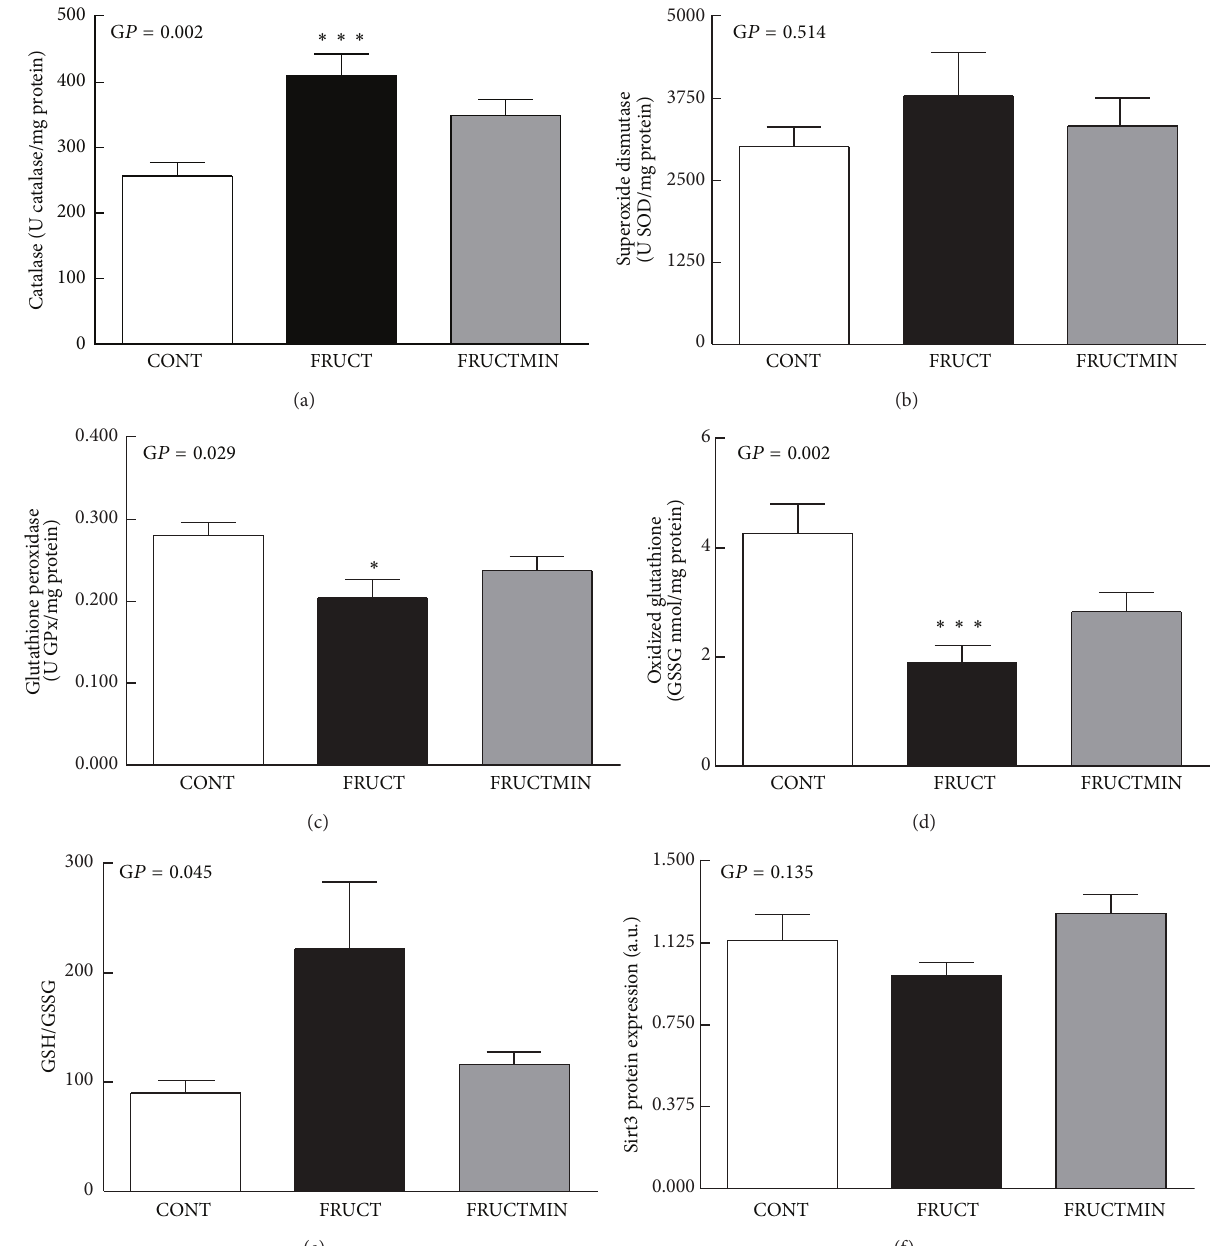
Figure 7: Redox state markers in liver. (a) Catalase (U catalase/mg protein; 𝑛 = 7 ), (b) superoxide dismutase (U SOD/mg protein; 𝑛 = 7 ), (c) glutathione peroxidase activities (U GPx/mg protein; 𝑛 = 7 ), (d) oxidized glutathione content (nmol/mg protein; 𝑛 = 7 ), (e) GSH to GSSG ratio ( 𝑛 = 7 ), and (f) sirtuin 3 protein expression (arbitrary units (a.u.); 𝑛 = 5 -6), at the end of the dietary intervention. Results were expressed as mean ± standard error of the mean. ∗ 𝑃 < 0.05 CONT versus FRUCT; ∗∗∗ 𝑃 < 0.005 CONT versus FRUCT. CONT: control; FRUCT: 10% fructose in tap water; FRUCTMIN: 10% fructose in natural mineral-rich water; G 𝑃 : global P ; GPx: glutathione peroxidase; GSH: reduced glutathione; GSSG: oxidized glutathione; Sirt3: sirtuin 3; SOD: superoxide dismutase.